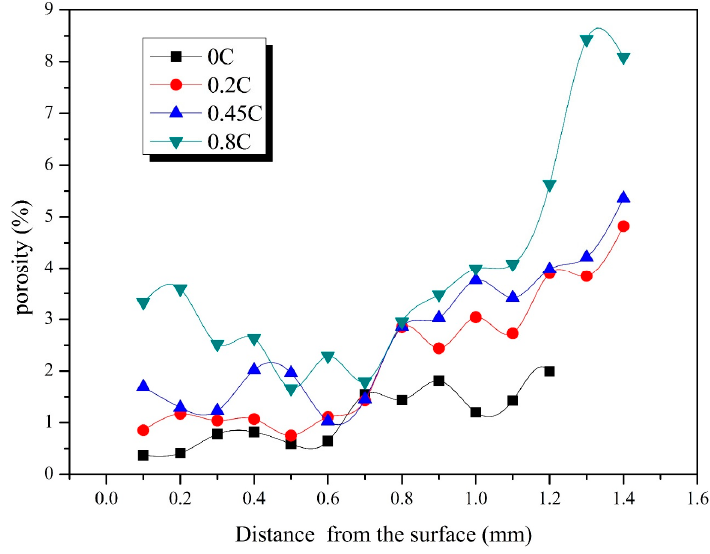
Figure 3. Porosity distribution on the cross-section in the surface layer.